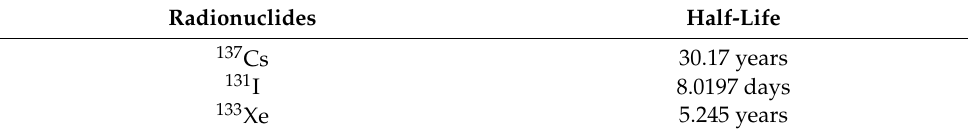
Table 2. Selected radionuclides.